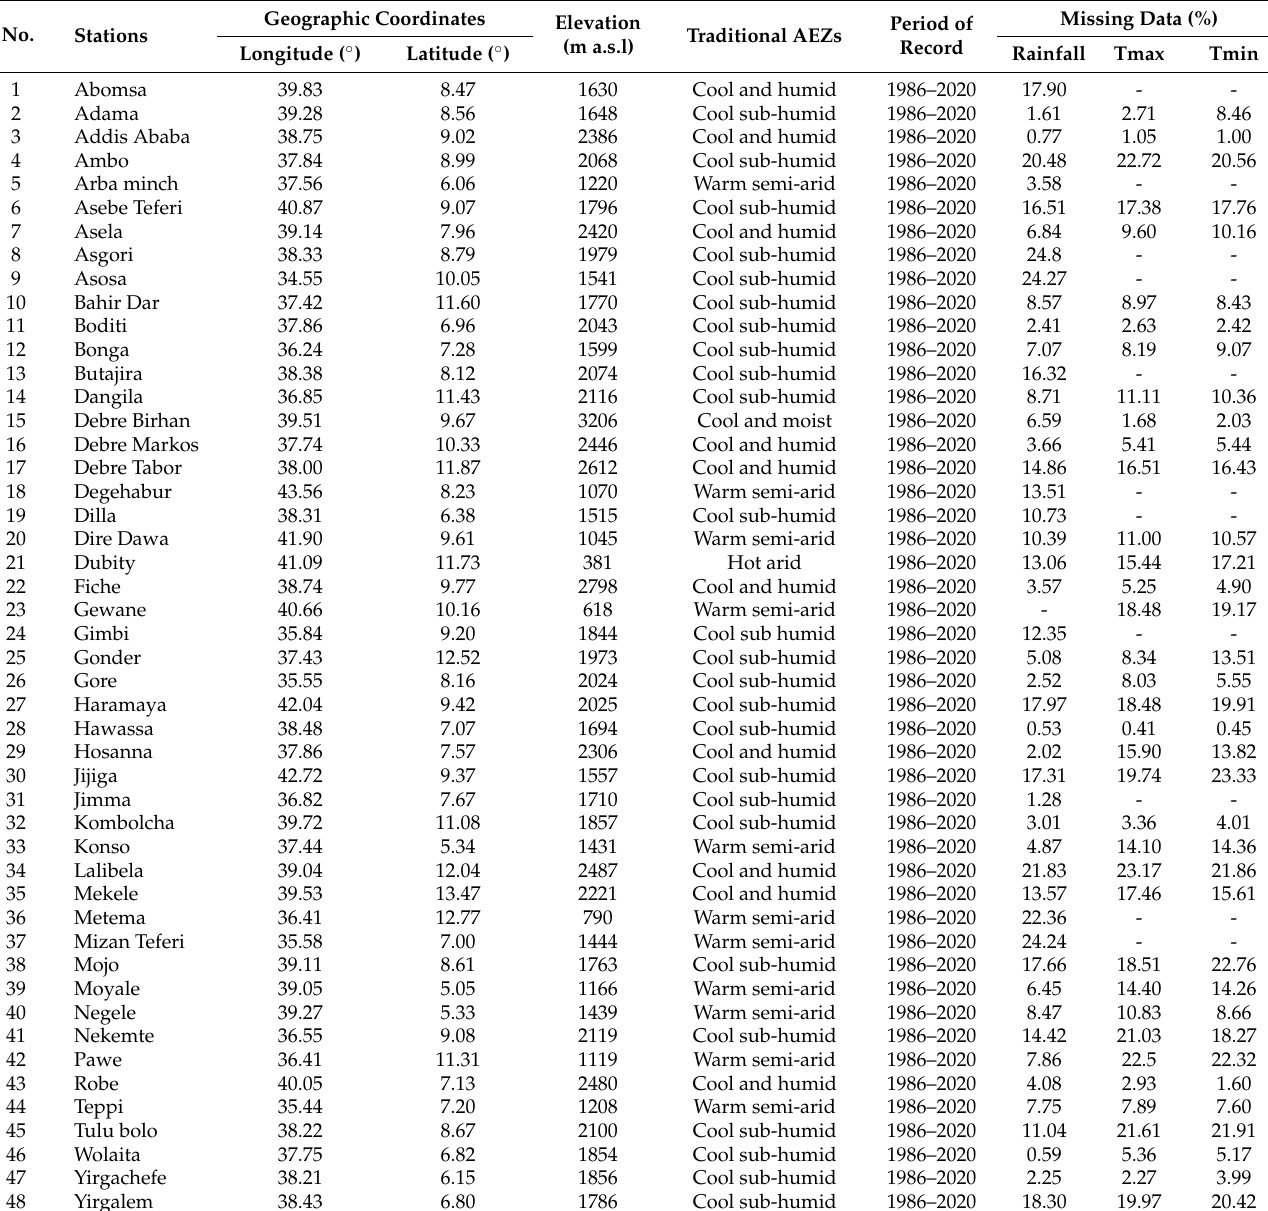
Table 1. Descriptions of the studied meteorological